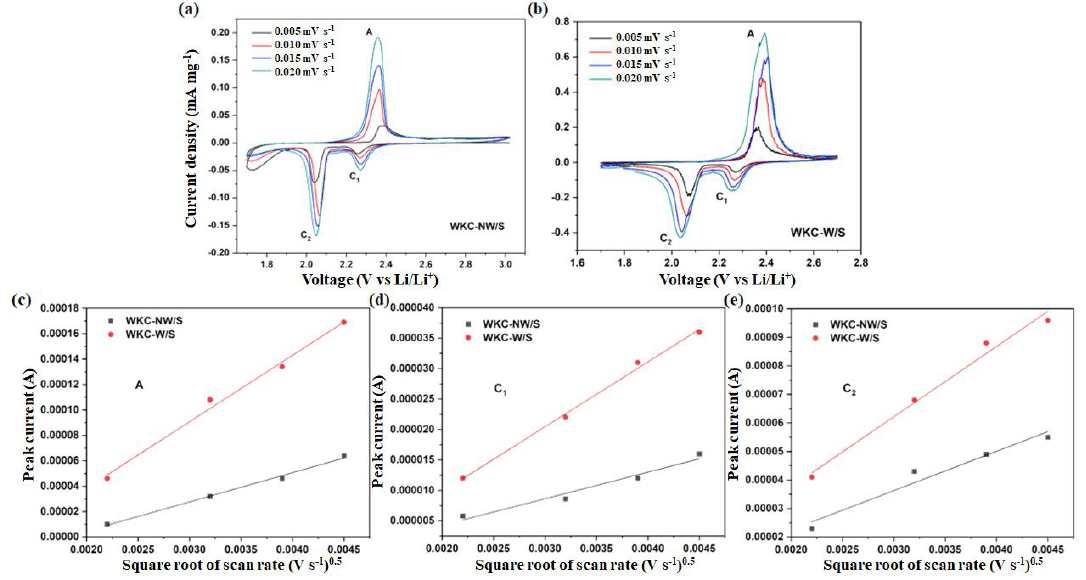
Figure 7. CV profiles for WKC-NW/S and WKC-W/S at various scan rate ( a , b ) and plots of the CV